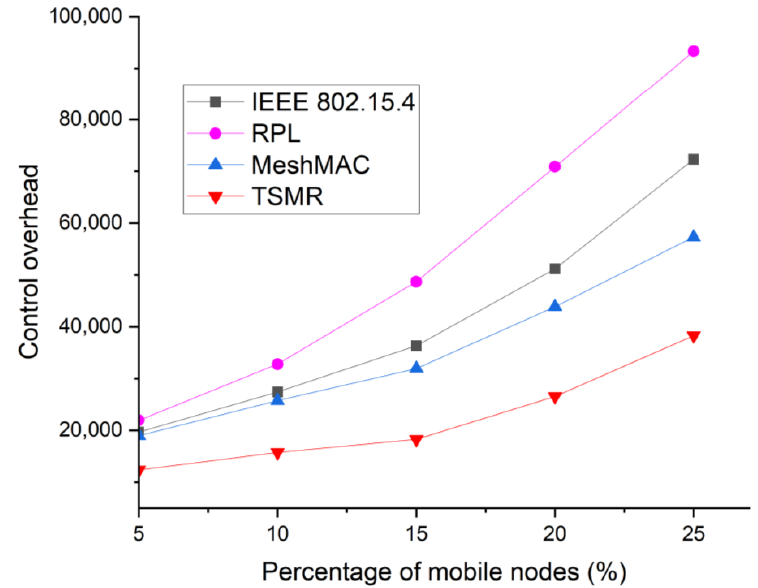
Figure 18. Control overhead as a function of the number of mobile nodes.